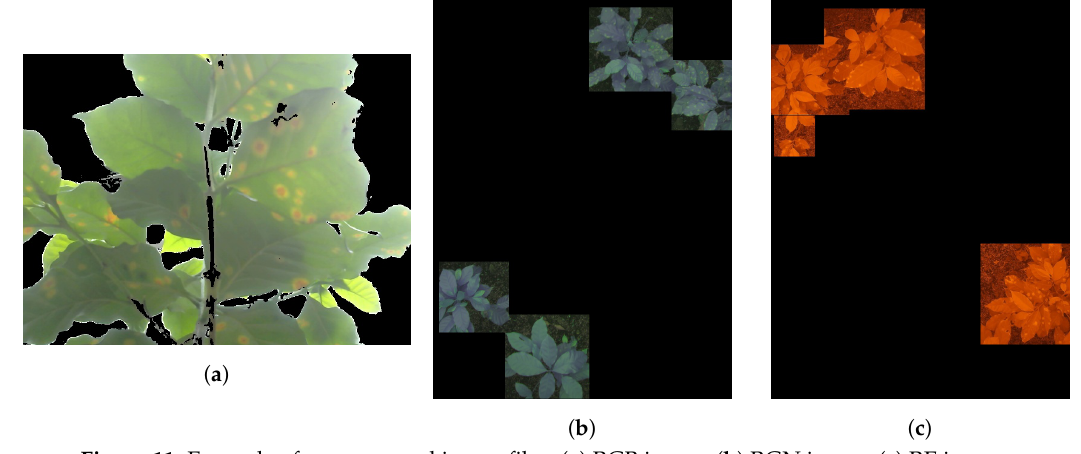
Figure 11. Example of preprocessed image files: ( a ) RGB image; ( b ) RGN image; ( c ) RE